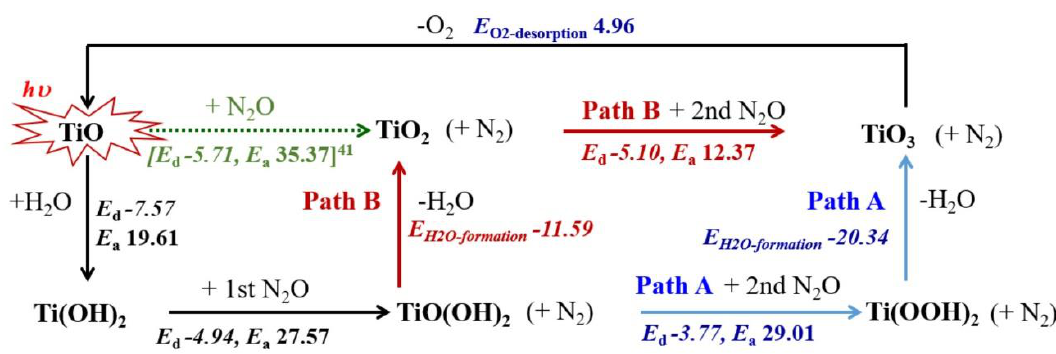
Figure 6. Full energy profile of N 2 O decomposition over the oxotitanium porphyrin.